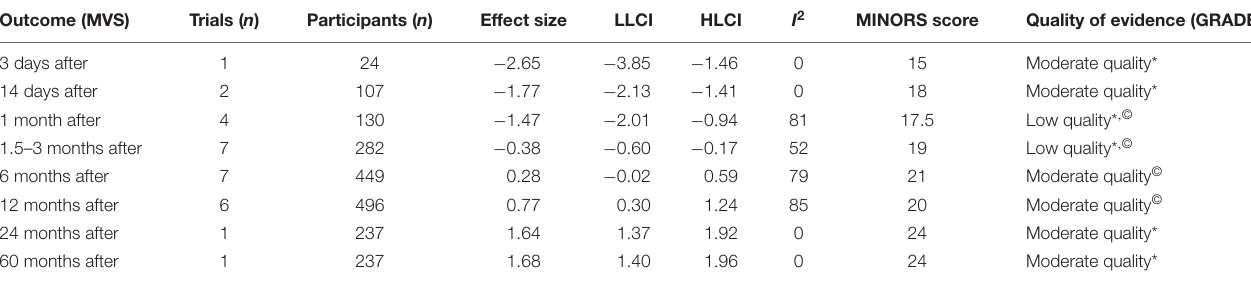
TABLE 2 | Quality of the evidence assessment using the Grading of Recommendations Assessment, Development, and Evaluation (GRADE) system.